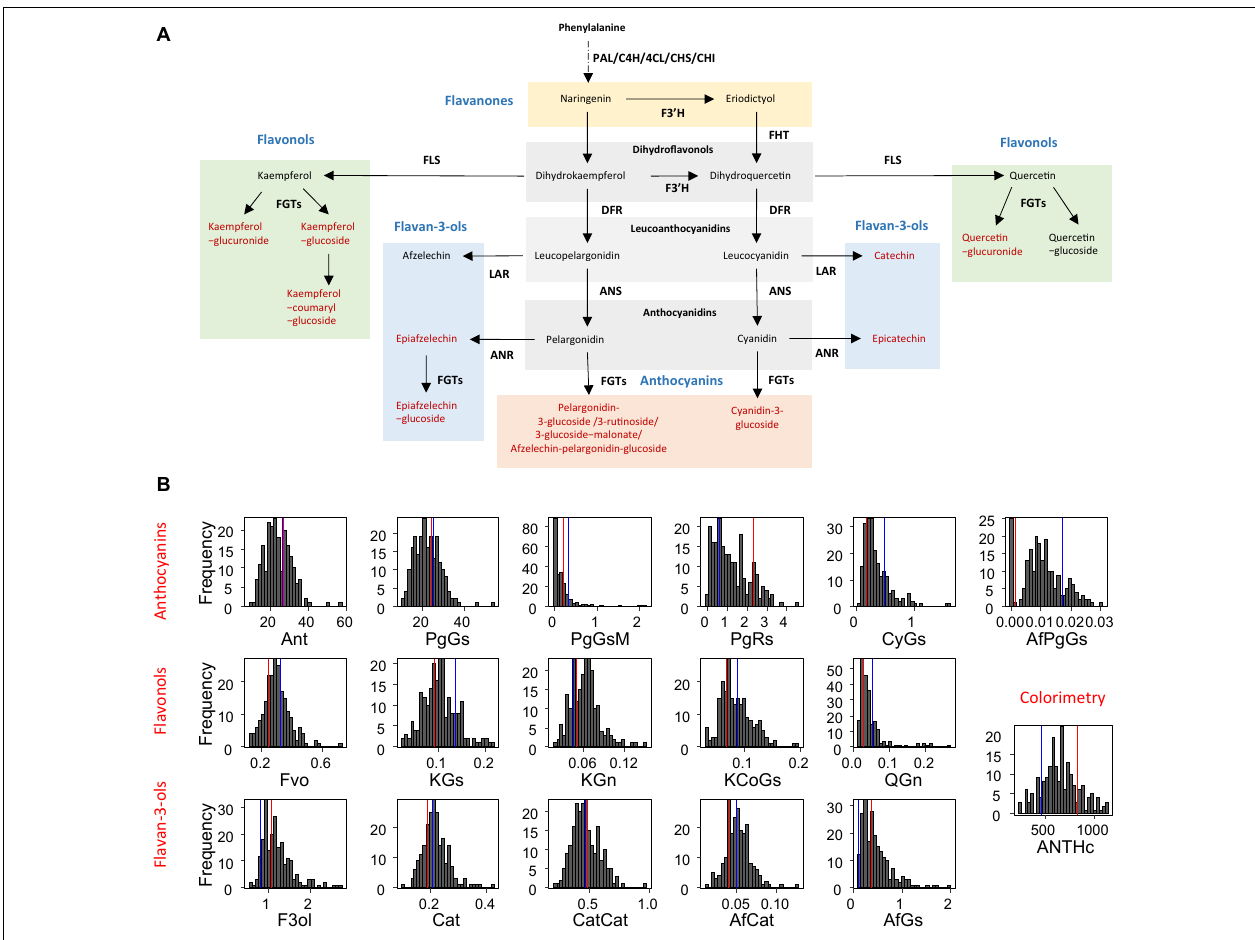
FIGURE 1 | Flavonoids of strawberry ( Fragaria × ananassa ) fruit and their distribution in the progeny. (A) Simplified flavonoid biosynthetic pathway. Compounds assessed in this study are in red. Chemical classes are in blue. ANR, anthocyanidin reductase; ANS, anthocyanidin synthase; CHI, chalcone isomerase; C4H, cinnamic acid-4-hydroxylase; 4CL, 4-coumarate:CoA ligase; CHS, chalcone synthase; DFR, dihydroflavonol-4-reductase; FGT, UDPglucose: flavonoid-3-O-glucosyltransferase; FHT/F3H, flavanone-3-hydroxylase; FLS, flavonol synthase; LAR, leucoanthocyanidin reductase; PAL, phenylalanine ammonia-lyase. (B) Distribution of the progeny mean in 2010. The mean phenotypic values of the parents are shown in red for “Capitola” and in blue for “CF1116.” Ant, Fvo, F3ol values were obtained by summation of total anthocyanins, total flavonols and total flavan-3-ols, respectively; PgGs, pelargonidin-3-glucoside; PgGsM, pelargonidin-3-glucoside-malonate; PgRs, pelargonidin-3-rutinoside; CyGs, cyanidin-3-glucoside; AfPgGs, (epi)afzelechin-pelargonidin-3-glucoside; KGs, kaempferol-glucoside; KGn, kaempferol-glucuronide; KCoGs, kaempferol-coumaryl-glucoside; QGn, quercetin-glucuronide; Cat, catechin; CatCat, (epi)catechin dimers; AfCat, (epi)afzelechin-(epi)catechin dimers; AfGs, (epi)afzelechin-glucoside; ANTHc, anthocyanins (colourimetry). The flavonoid metabolites values are expressed as mg-equ/100 g FW assuming a response factor of 1. ANTHc results are expressed as mg pelargonidin-3-glucoside equivalents/100 g FW.